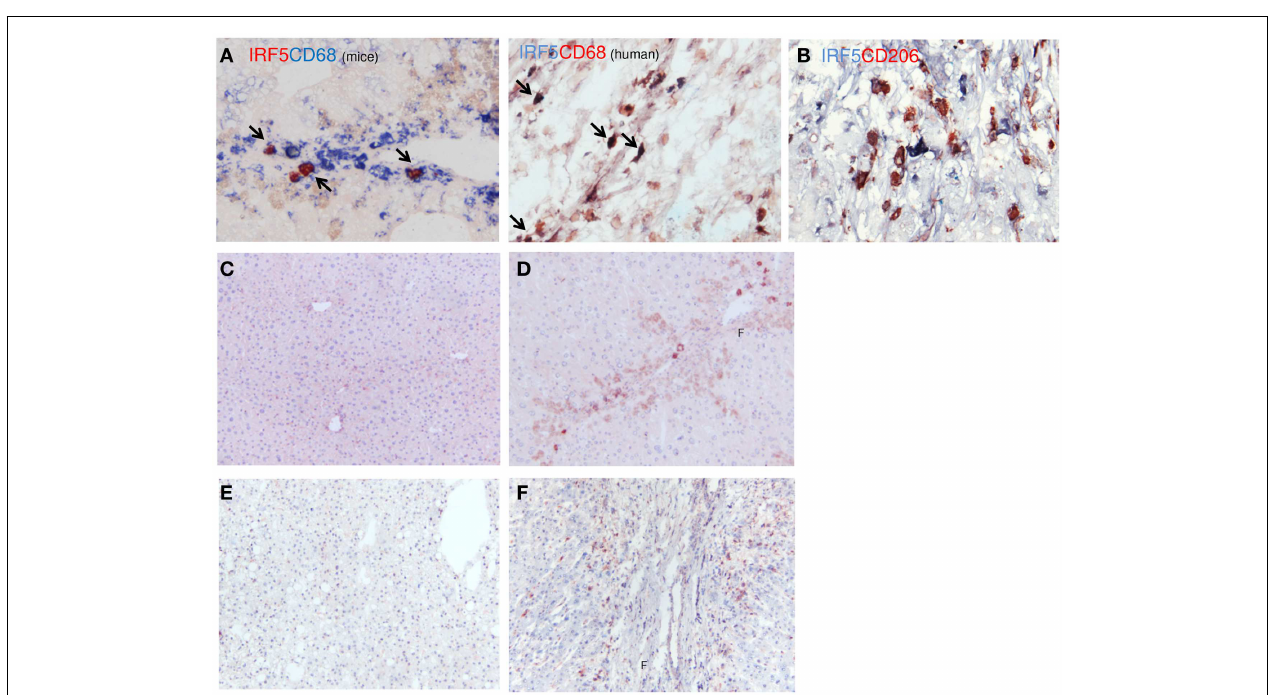
mice livers (C) and in livers after chronic CCl4 damage (D) . (E,F) IRF-5 staining of normal (E) and cirrhotic (F) human livers. f, fibrotic matrix. Magnifications: